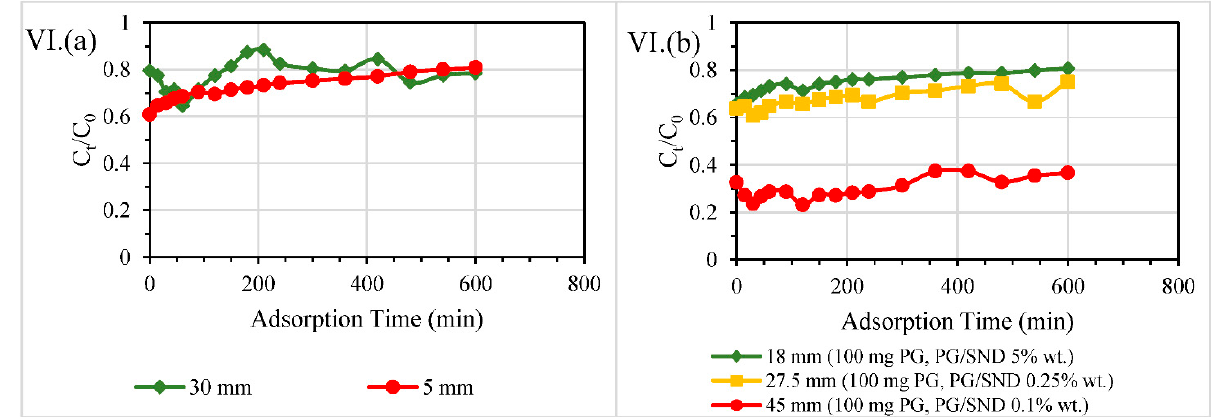
Figure 7. ( I ) ATL, ( II ) CBZ, ( III ) CIP, ( IV ) DCF, ( V ) GEM, ( VI ) IBP adsorption onto PG/SND filter medium of different heights in various column sizes ( a ) 18 mm ID ( b ) 40 mm ID. Experimental conditions: ECs-contaminated DW influent adjusted at 10.5 mg/L of EC; room temperature at 22 ± 3 °C. Table 1. Hydraulic retention time and overall removal efficiency of ATL removal by column filters of different cross sectional areas, PG doses, and packing heights at constant dosage. Experimental conditions: ECs-contaminated DW influent adjusted at 10.5 mg/L of EC; room temperature at 22 ± 3 ◦ C.